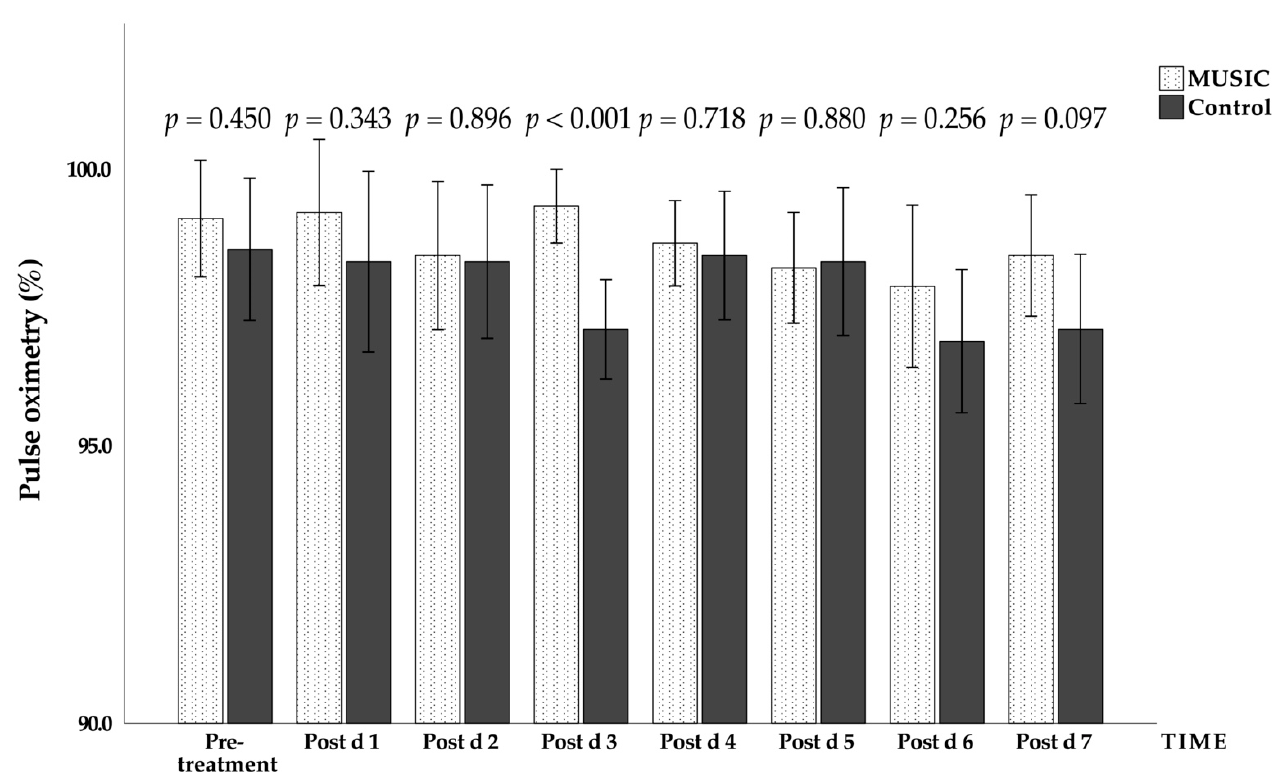
Figure 2. Daily changes in the visual analogue scale for pain in the music group and the control group during the experiment. Mean ± standard error (error bar: 95% CI). Post d, post-treatment day.